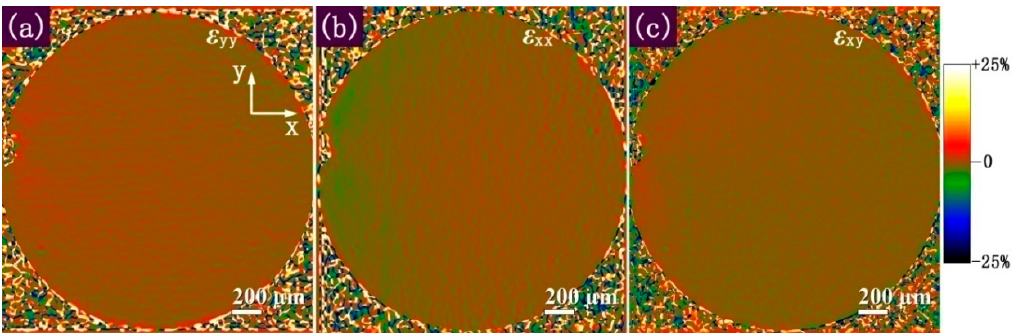
Figure 4. Strain fields at 150 N during the increasing load corresponding to Figure 3b measured by using the GPA method: ( a ) ε yy strain field; ( b ) ε xx strain field; ( c ) ε xy strain field.